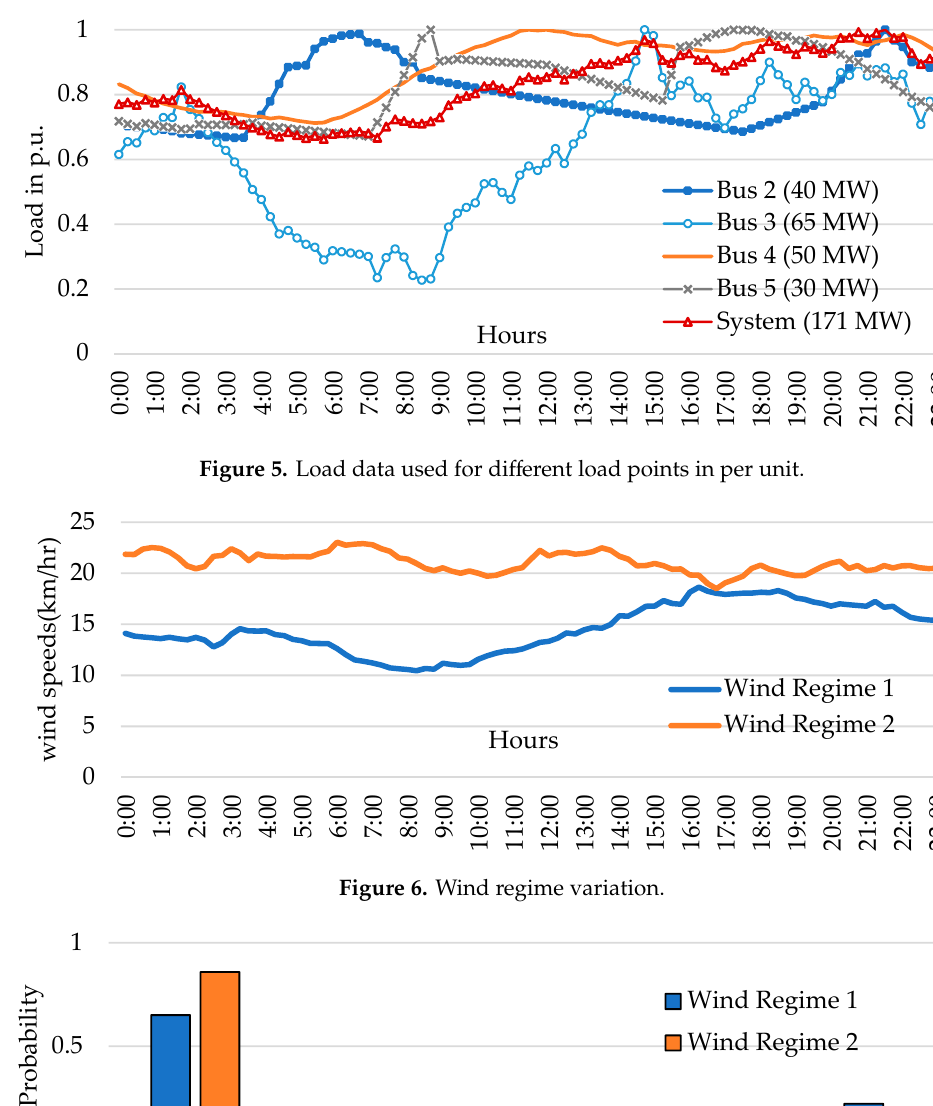
Figure 4. Test system.